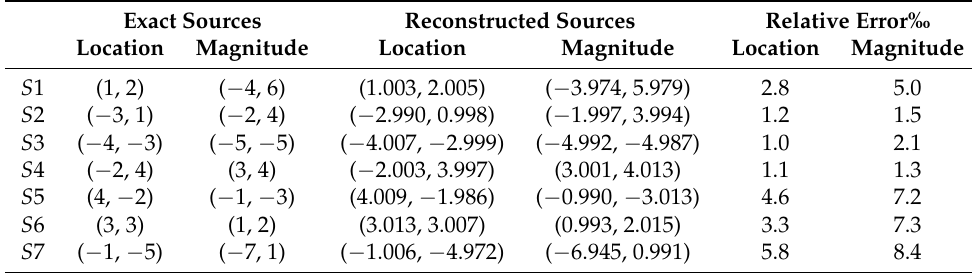
Table 7. Reconstruction of the location and magnitude of seven point